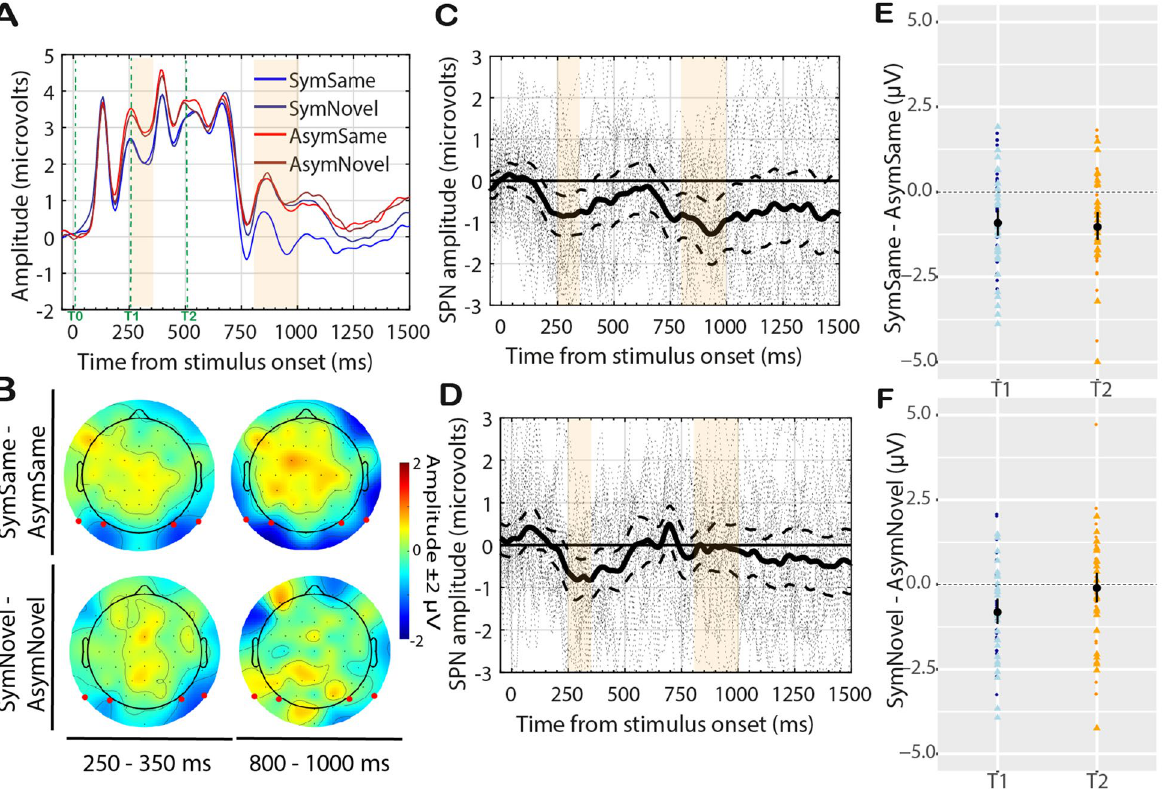
Figure 5. Experiment 2 Results. Conventions are the same as in Fig.